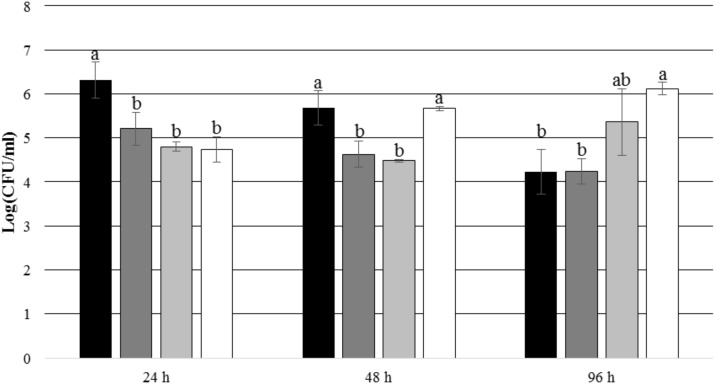
Number of attached P. inhibens wt and P. inhibens ΔtdaB with E. huxleyi is present inside the chamber. Grouping based on ANOVA post hoc Tukey test. Groups within each sampling time that do not share a letter are significantly different (24 h: P = 0.001; 48 h: P = 0.000; 96 h: P = 0.003).
P. inhibens wt with E. huxleyi, experimental membranes;
P. inhibens wt with E. huxleyi, control membranes;
P. inhibensΔtdaB with E. huxleyi, experimental membranes;
P. inhibensΔtdaB with E. huxleyi, control membranes.